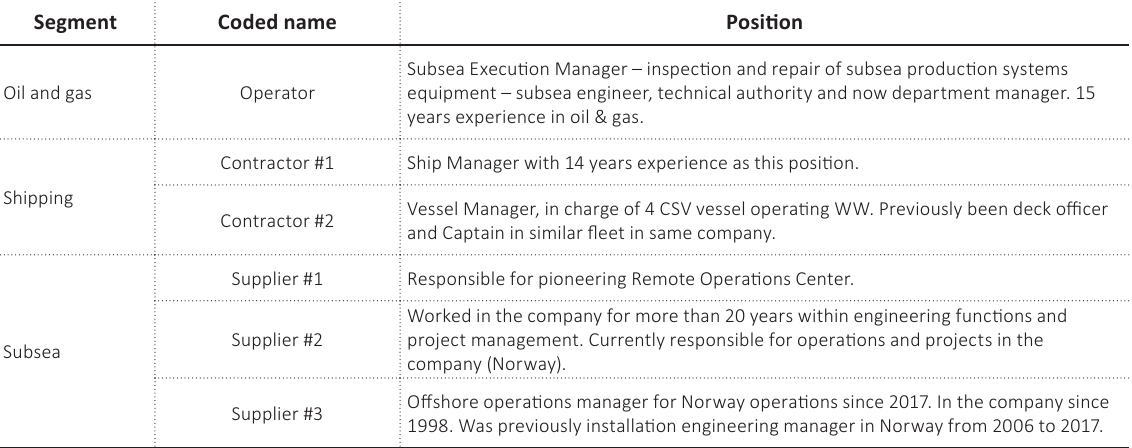
Table 1. Case description and collected data